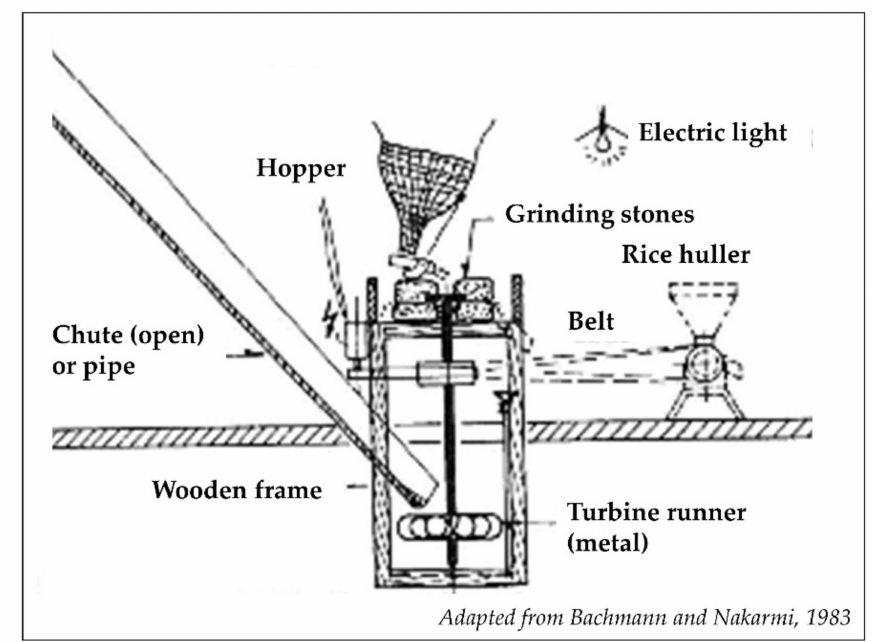
Figure 3. New Nepali water mills for improved